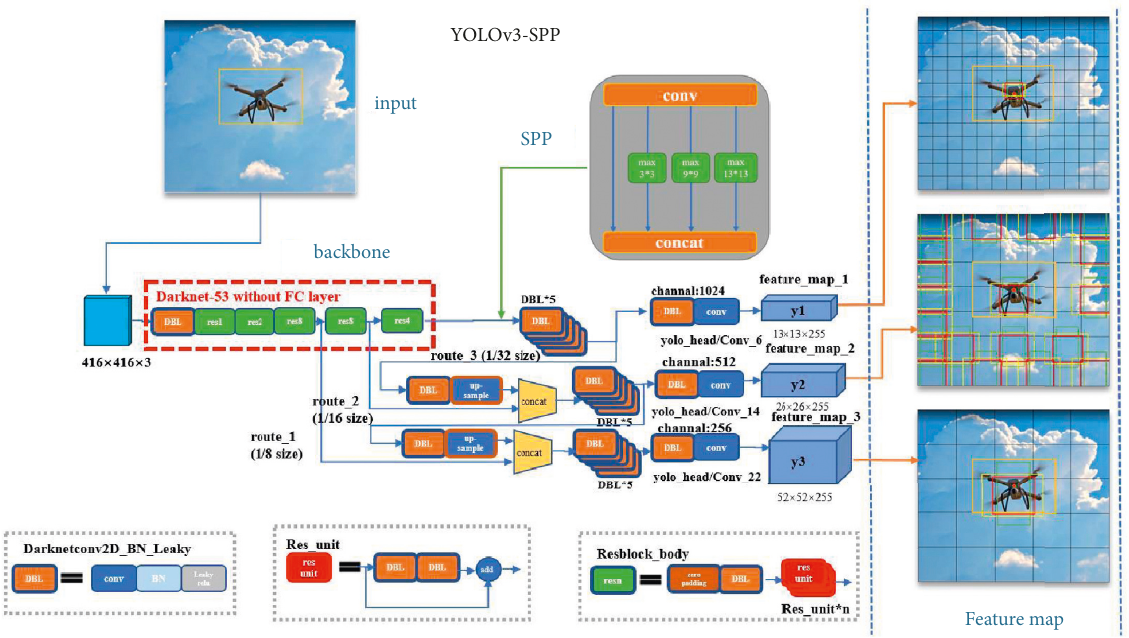
Figure 5: Workflow of the YOLOv3 algorithm.